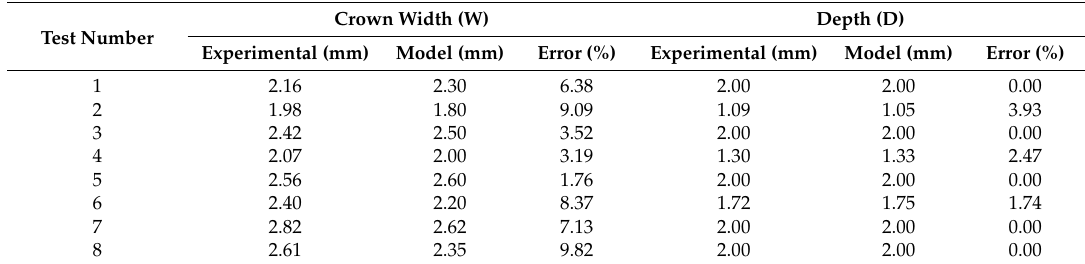
Table 6. Geometrical validation of the model (width and depth).